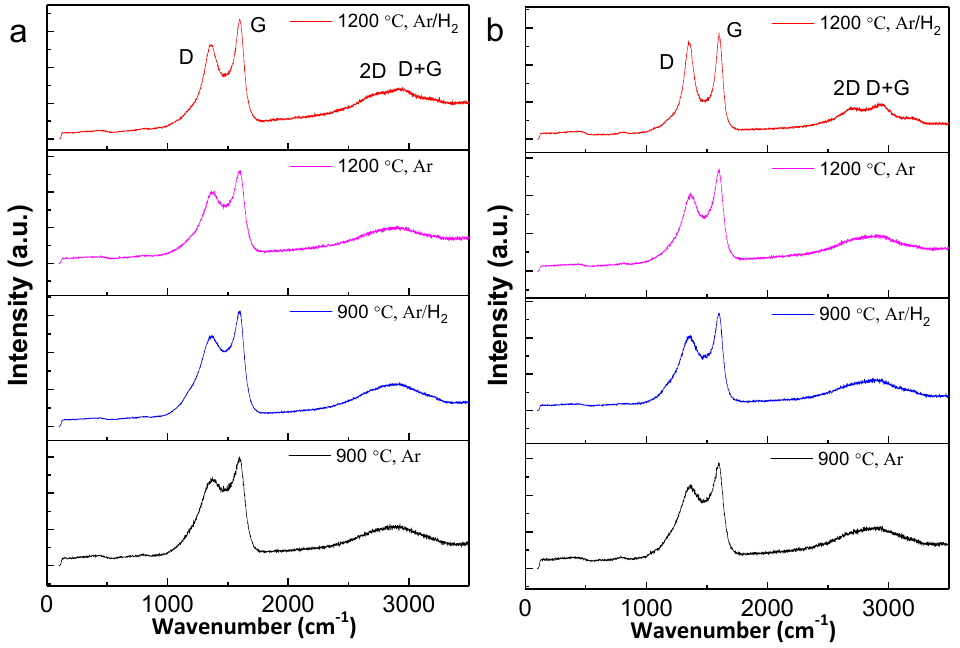
Figure 1. Raman spectra of (N)G prepared from chitosan ( a ) and G prepared from alginic acid ( b ) pyrolyzed at 900, 1200 °C under Ar or Ar/H 2 (5%) flow, respectively. Table 1. Parameters determined from the Raman spectra to assess the influence of the pyrolysis temperature and H 2 concentration on the defect density on the resulting graphene films 1 .